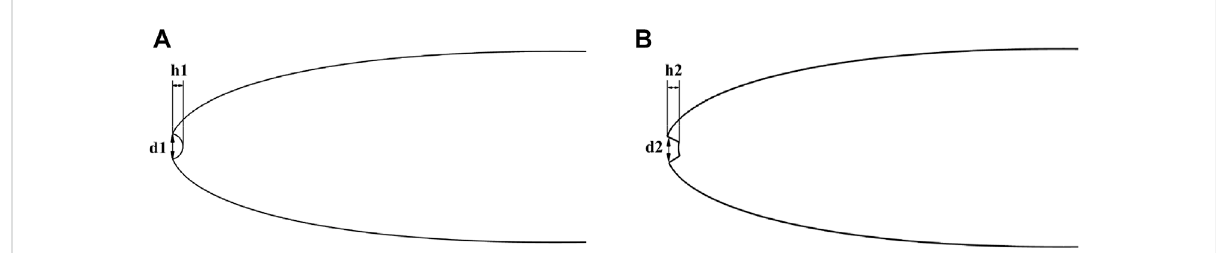
FIGURE 1 Two erosion shape applied on airfoil leading edge. ( (A) : Semi-circleerosion; (B) : Square erosion).